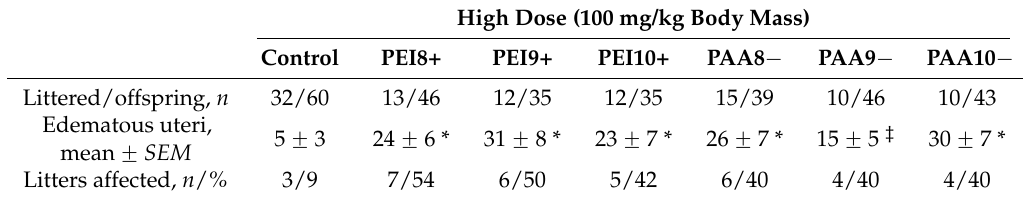
Table 5. Incidence of edematous uteri (EU) for offspring exposed to 100 mg/kg of iron oxide NPs on GD 8, 9, or 10 in utero . * Significant differences between treatment and control ( p < 0.05). ‡ Trends between treatment and control at ( p < 0.1).